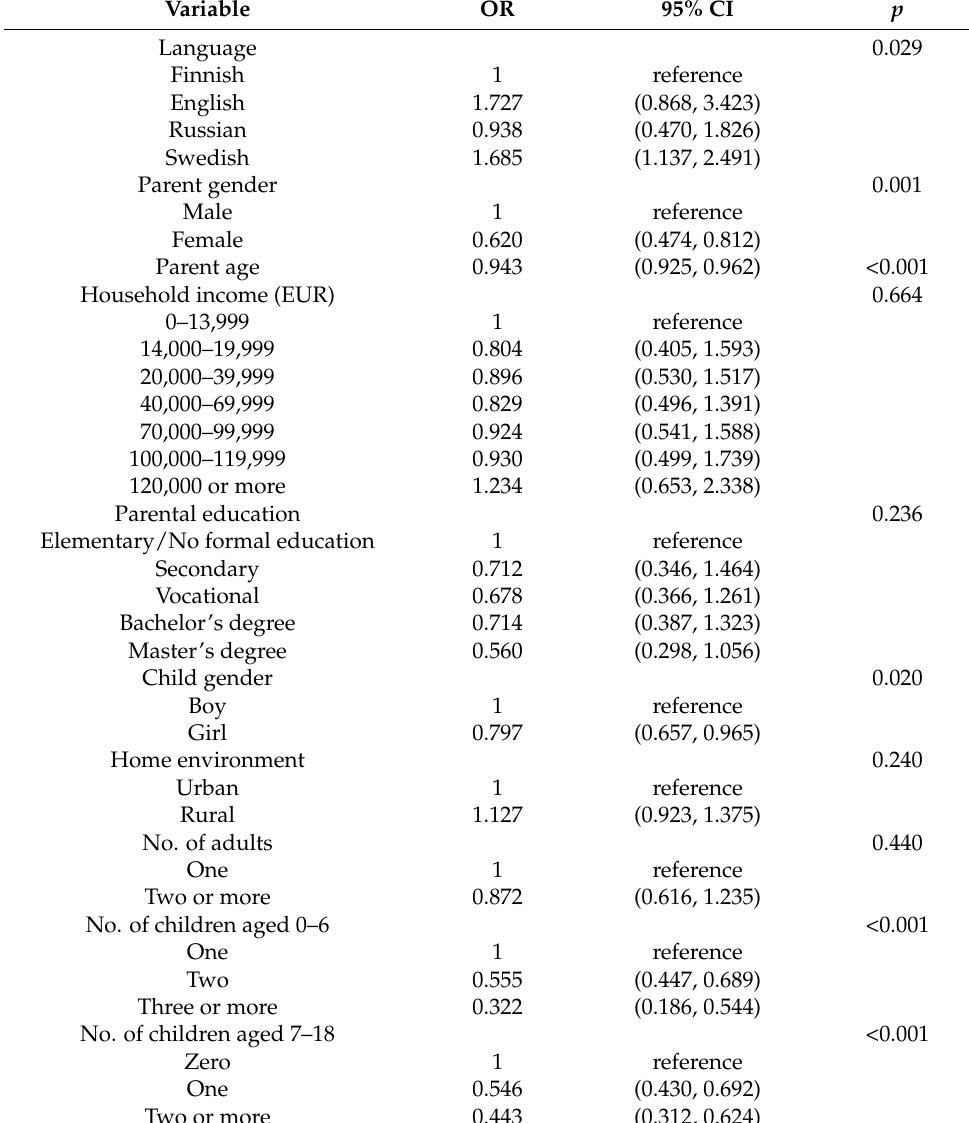
Table 5. Odds ratios (OR) of sociodemographic variables to parental participation in child’s physi- cal play.